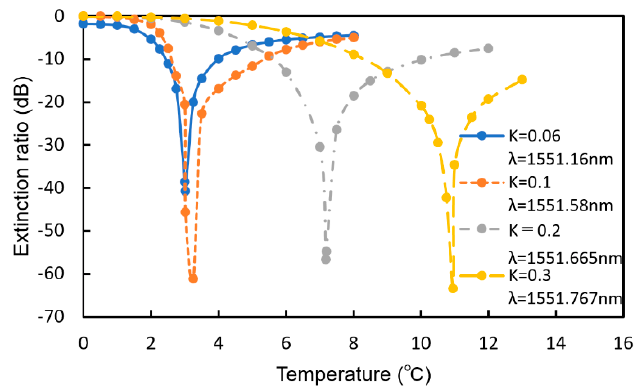
Figure 16. Extinction ratio as a function of the increase in temperature for various K .